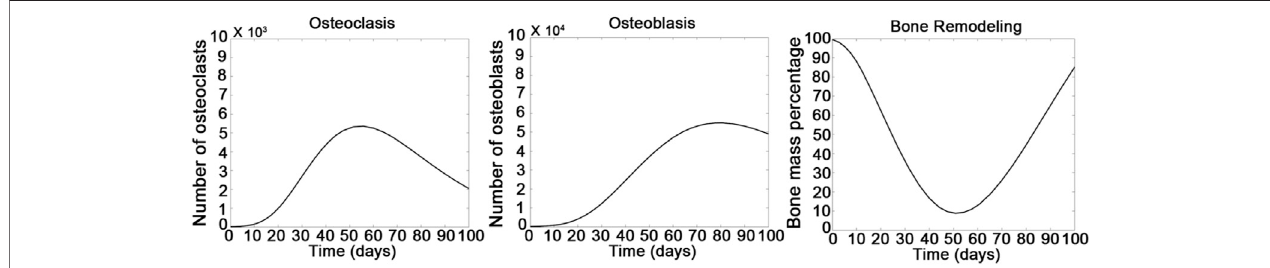
FIGURE 3 | Computational calculation was designed for temporal patterning of the growth of osteoclasts, osteoblasts, and bone remodeling. Calculation was performed by setting the following parameters in Eq. (1 – 3) . ( α 1 = 3, α 2 = 4, β 1 = 0.125, β 2 = 0.035, g 11 = 1.25, g 12 = 0.75, g 21 = -0.5, g 22 = 0).